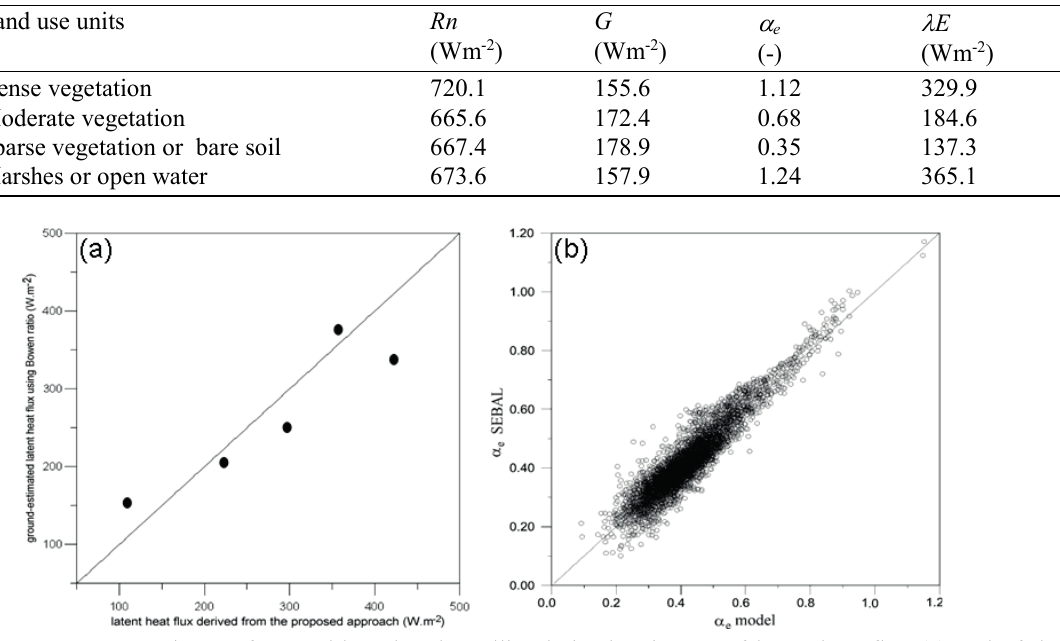
Fig. 4 Comparisons of ground-based and satellite-derived estimates of latent heat flux (a) and of the proposed approach and SEBAL model estimates of the α e parameter